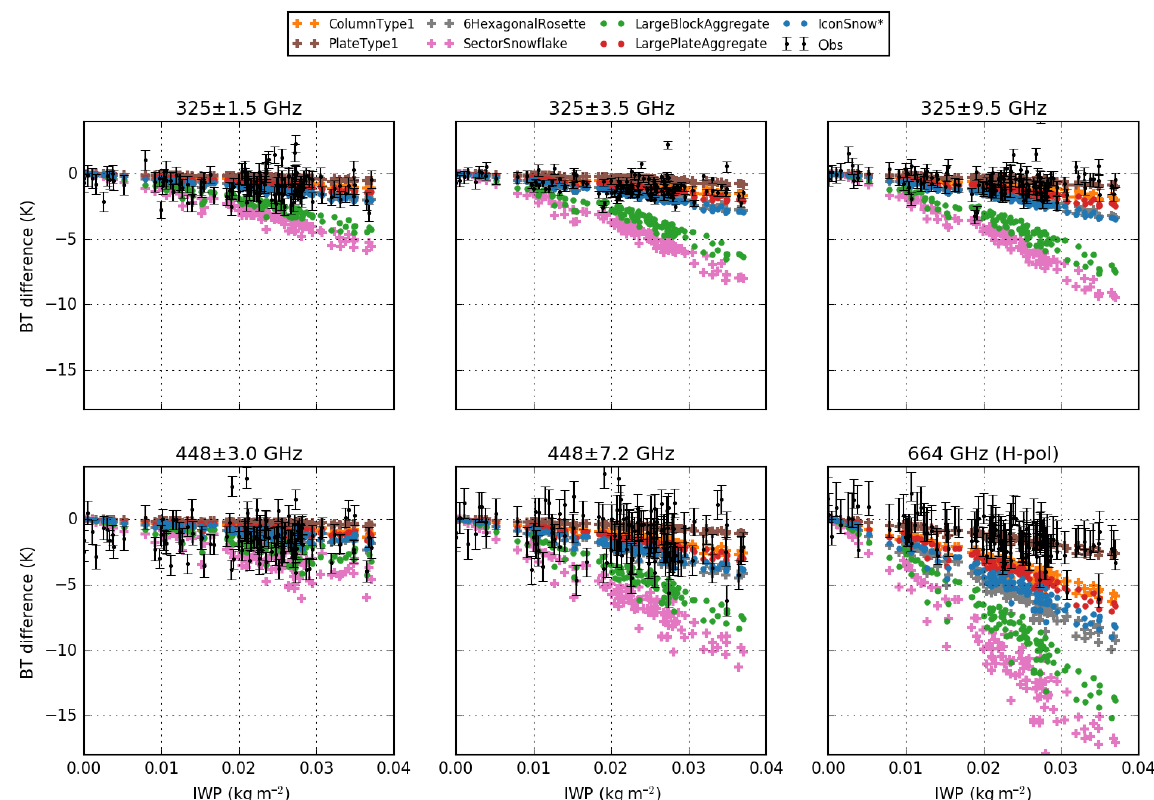
Figure 10. Cloud-induced brightness temperature differences as a function of ice water path for